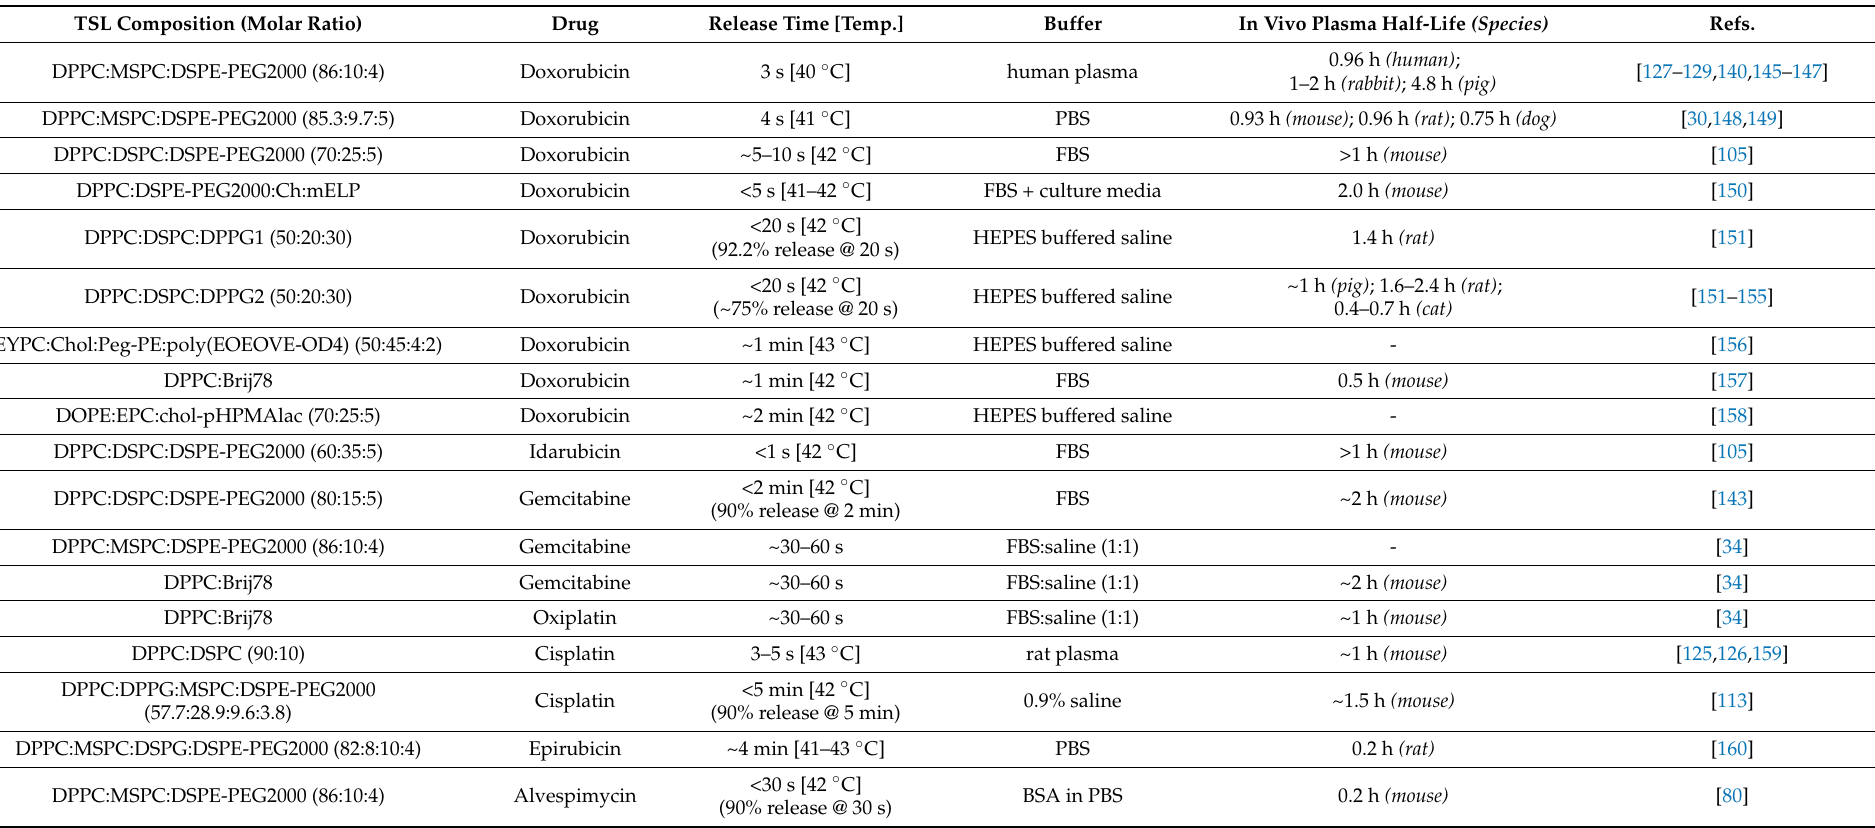
Table 1. Fast-release TSL formulations. Release times (see Figure 7) were estimated if possible, or an upper limit was provided (e.g., <20 s); in the latter cases, release at the first measured time point is shown in brackets. Buffer used for release measurement is indicated, since buffer affects release kinetics [121]. TSL Composition (Molar